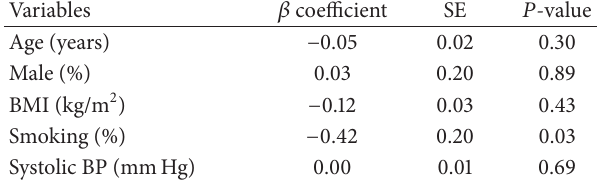
𝑟 2 = 0.35 . Variables included in the stepwise model for mtDNA were age, sex, BMI, alcohol consumption, smoking, systolic BP, total cholesterol, HDL-cholesterol, fasting glucose, HOMA-IR and visceral fat area. To avoid multi-collinearlity, diastolic BP, triglycerides and subcutaneous fat area were not included in the stepwise model. # Values analyzed after log-transformation to correct for skewed distribu- tion. (b) Non-stepwise